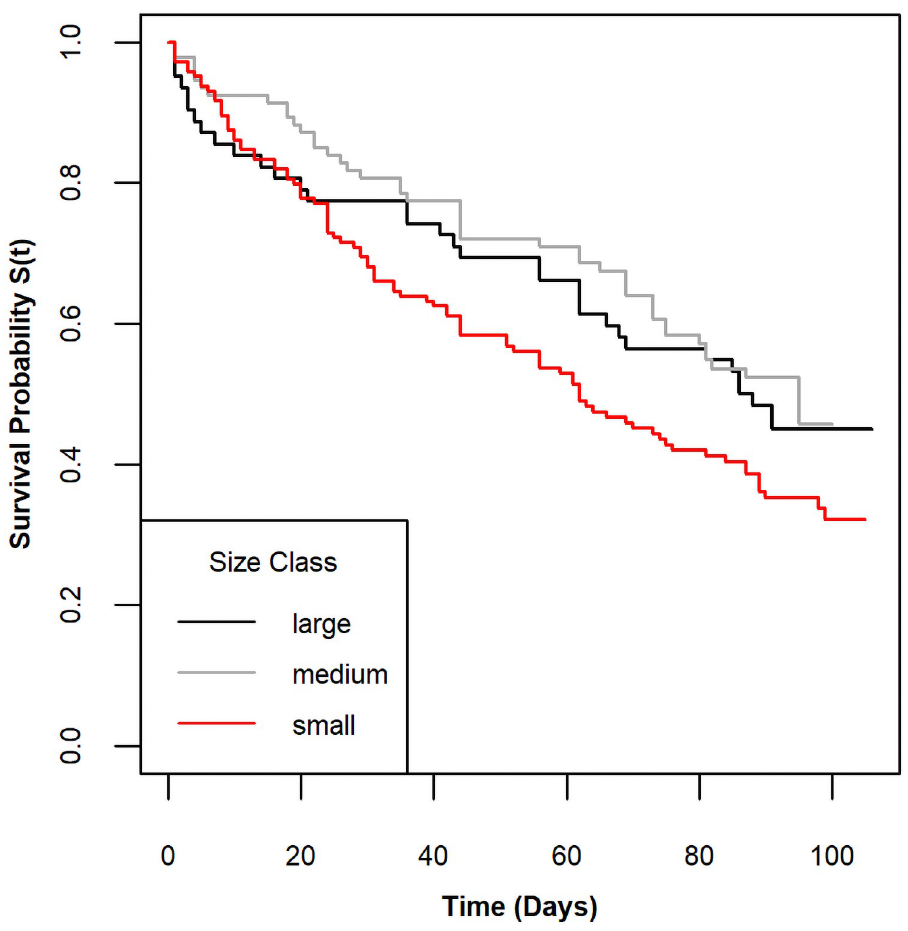
Fig 2. Kaplan-Meier survival curves by size class. Crab cohort classification is based on the following sizes: Large > 60 mm, medium � 60 mm and > 30 mm, and small � 30 mm. KM curves for large crabs are in black, medium crabs are in gray, and small crabs are in